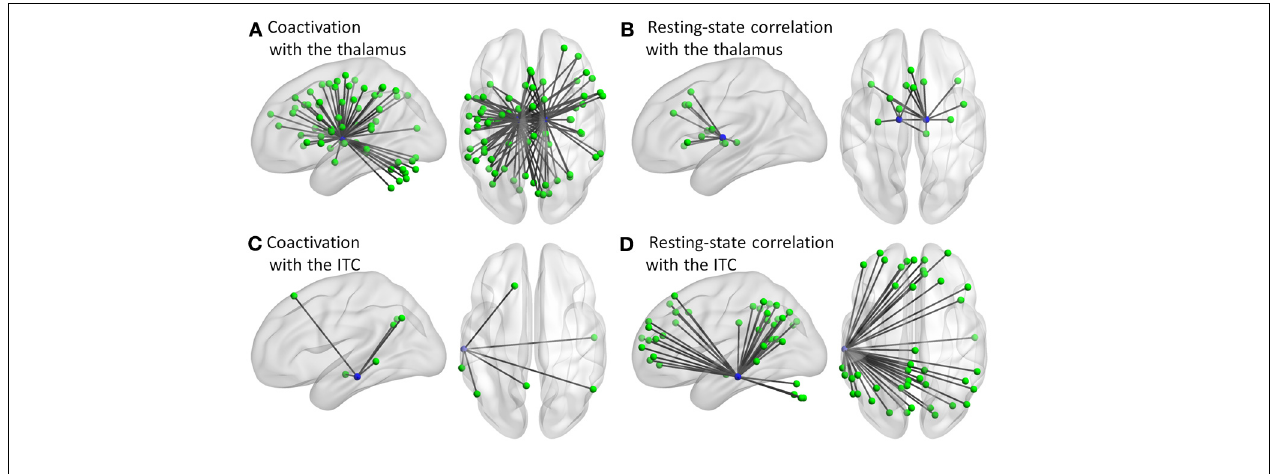
FIGURE 6 | Connectivity of the thalamus (A,B) and left inferior temporal cortex (ITC) (C,D) for the coactivation (A,C) and resting-state correlation (B,D) networks at sparsity of